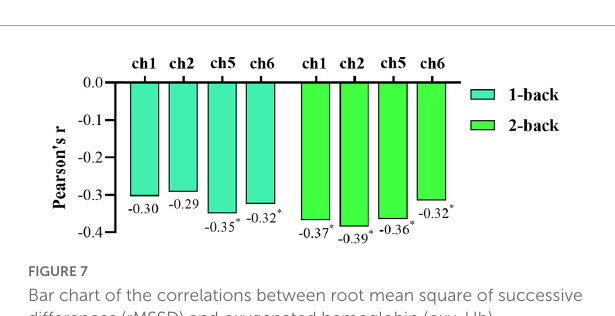
FIGURE7 Bar chart of the correlations between root mean square of successive differences (rMSSD) and oxygenated hemoglobin (oxy-Hb) concentration during the 1-back and 2-back tasks. An asterisk ( ∗ ) indicates statistical